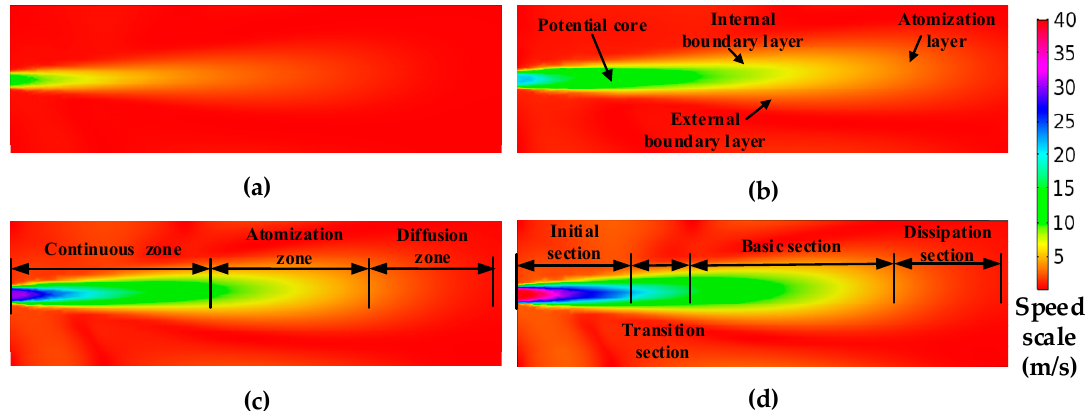
Figure 2. Steady-state flow field velocity cloud map with different jet velocities (leakage hole 60 mm). (a) 10 m/s; (b) 20 m/s; (c) 30m/s; (d) 40 m/s.